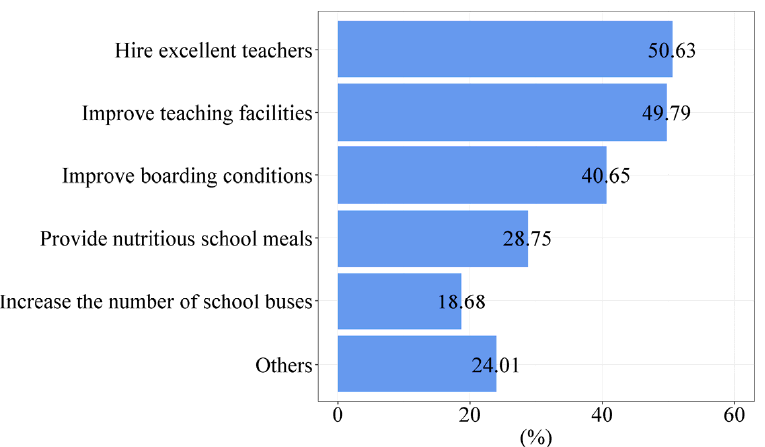
Figure 8. Areas where rural residents think the township elementary school their children attend needs improvement (Source: by the authors). needs improvement (Source: by the